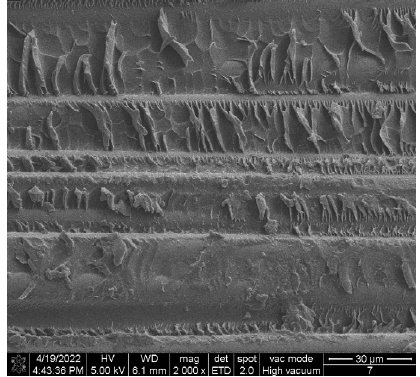
Figure 7. Micromorphology of #2’s mandrel.